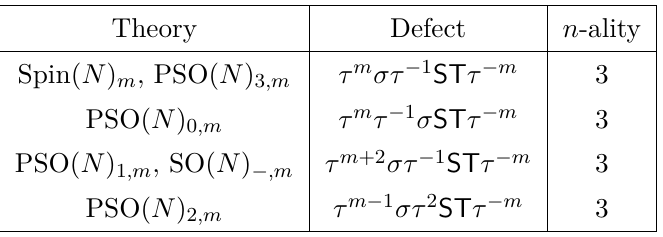
Table 8 . Non-invertible symmetries of so ( N ) with N ∈ 4 Z + 2 at τ YM = e 2 πi/ 3